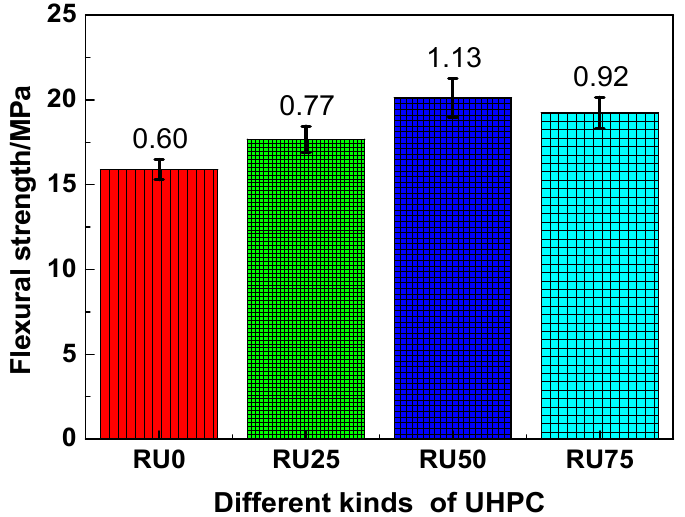
Figure 6. The flexural strength RS-UHPC with different contents of GO.